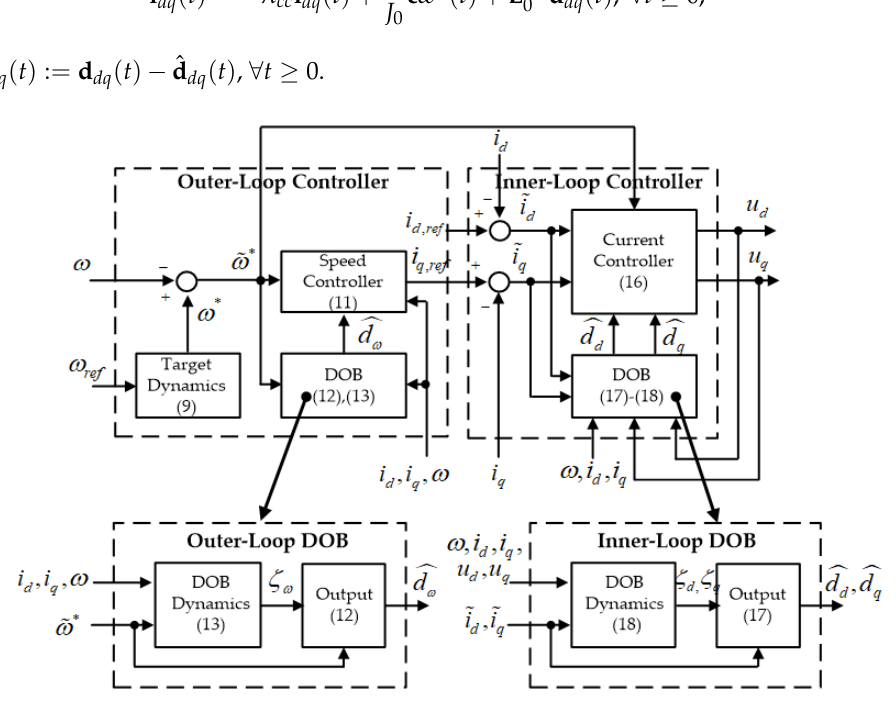
Figure 1. Proposed controller